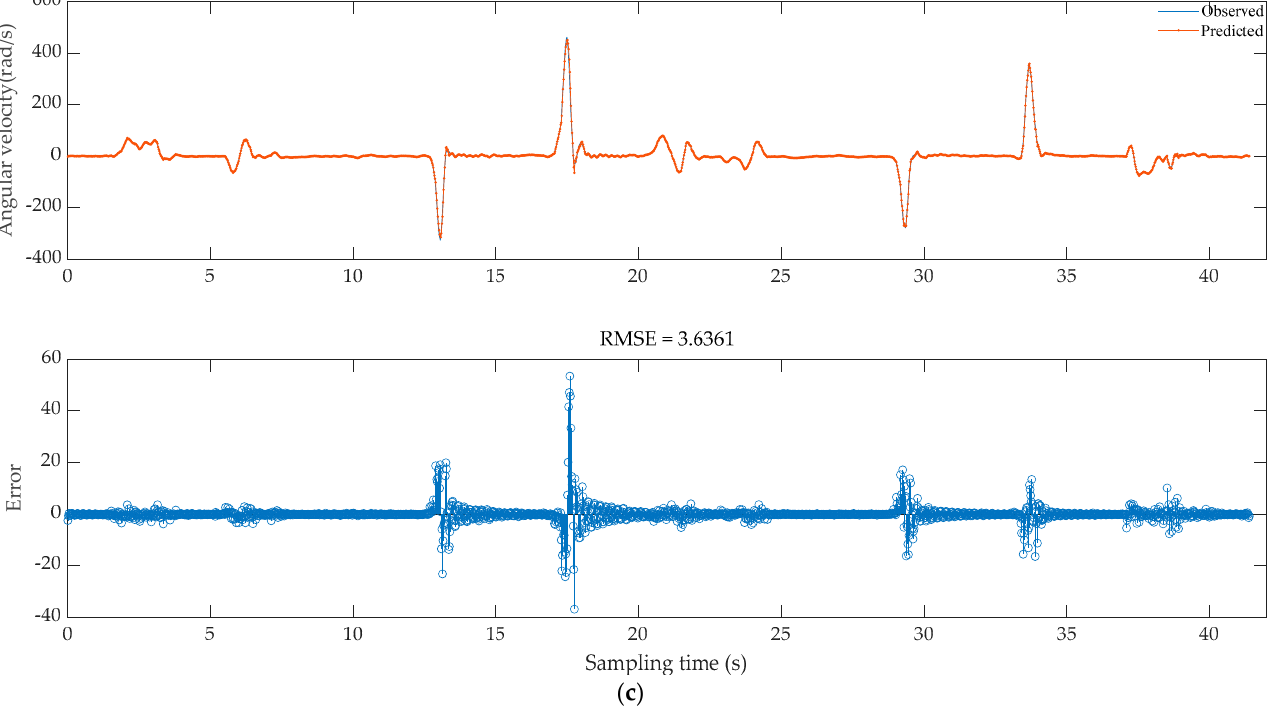
Figure 8. Predicted results for the three actions. ( a ) Root mean square error of putting on socks. ( b ) Root mean square error of putting on shoes. ( c ) Root mean square error of tying lace socks. Table 5. Root mean square error of three actions. Putting on Socks Putting on Shoes Tying Shoe